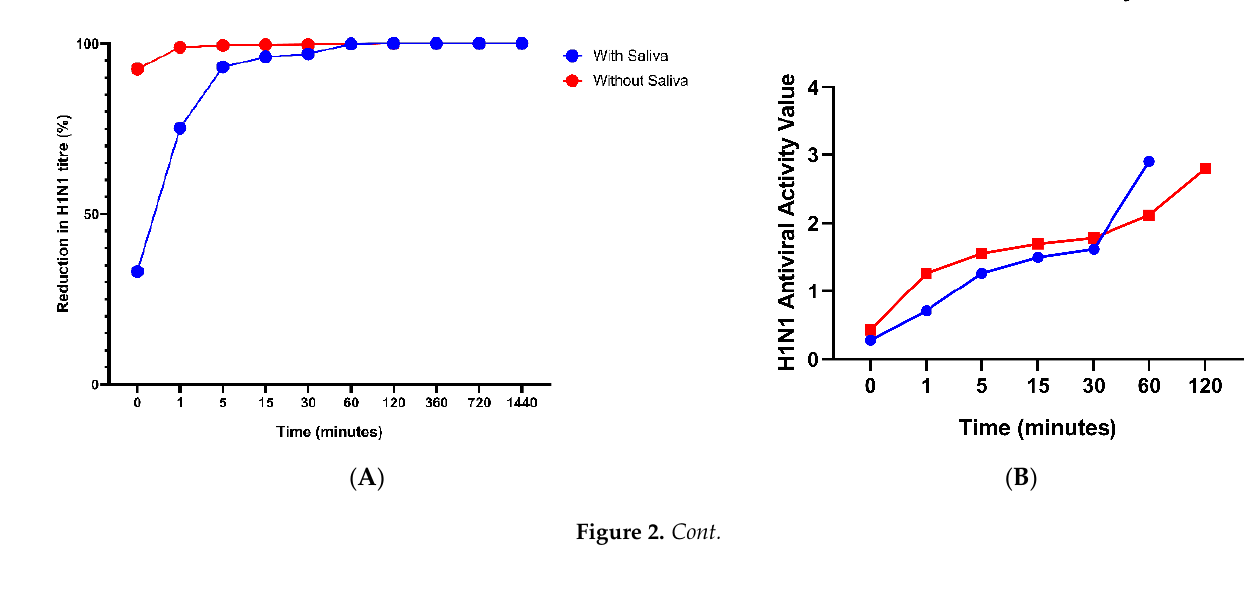
Figure 1. Inactivation of H1N1 and SARS-CoV-2 when in contact with a Viruferrin treated fabric material. 20 mm × 20 mm pieces of treated (Viruferrin-treated) and untreated (Cotton) control fabric samples, with ( A , C ) and without ( B , D ) the application of saliva, were assessed for anti-viral capabilities at 10 timepoints over a total time period of 1440 min with a limit of detection below 10 3 PFU. The bars represent geometric mean titers and the standard deviations are shown with error bars. Data was analyzed for significance using a 2-way ANOVA with Sidak’s multiple comparisons test (alpha = 0.05, p **** =< 0.0001 with * p value = 0.0162) comparing Viruferrin-treated and cotton control fabric samples at each